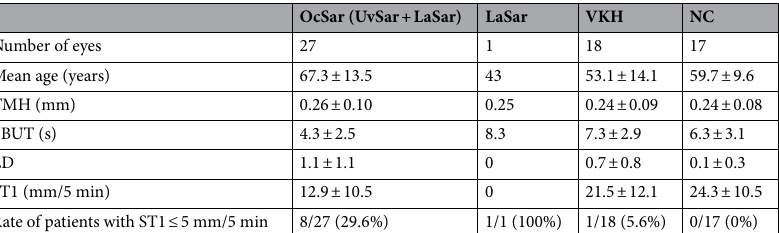
Table 1. Demographic data of the ocular sarcoidosis (OcSar) group, Vogt–Koyanagi–Harada disease (VKH) group, and normal control (NC) group. Values are mean ± SD. UvSar uveitis sarcoidosis, LaSar lacrimal sarcoidosis, FBUT fluorescein breakup time, TMH tear meniscus height, ED keratoconjunctival epithelium disorder, ST1 Schirmer 1 test.